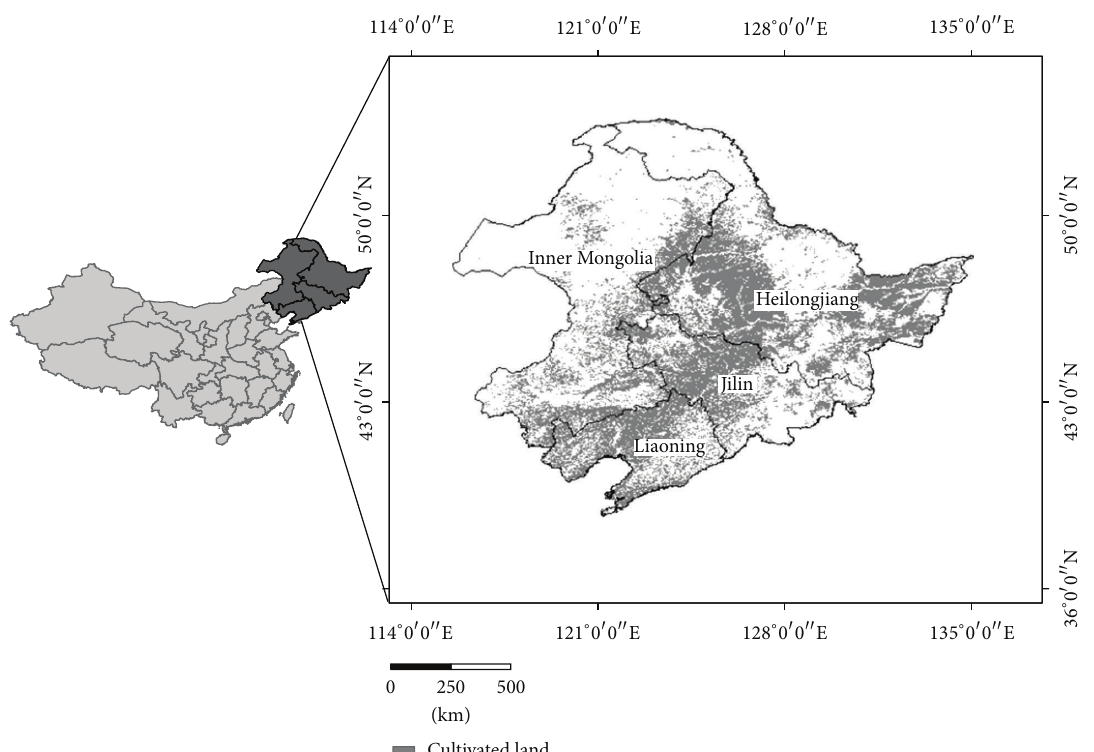
Figure 1: Location of Northeast China. Northeast China covers Heilongjiang Province, Jilin Province, Liaoning Province, and the northeast part of Inner Mongolia Autonomous